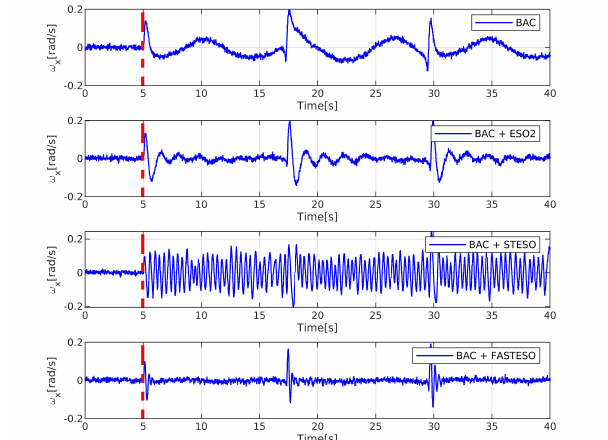
Figure 11. Results of roll angle with unknown external torque disturbance under backstepping controller combined with nothing, ESO2, STESO and FASTESO.